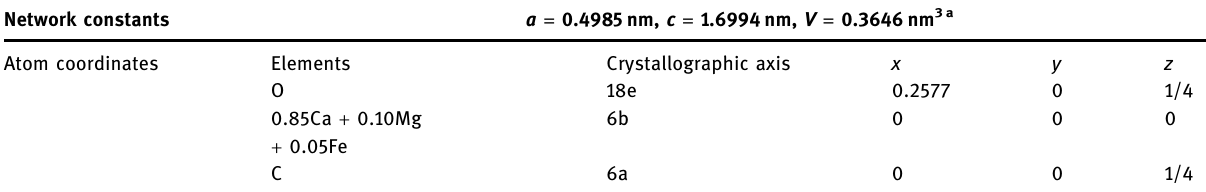
Table 6: Network constants and atom coordinates of the atoms of freshly precipitated deposit Network constants